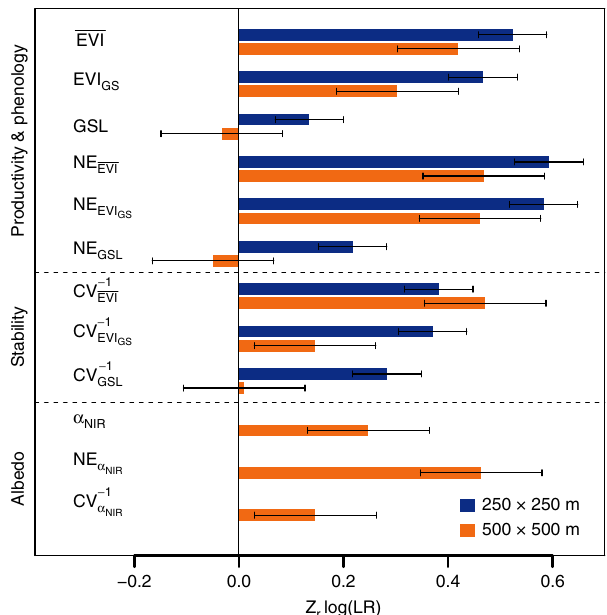
Fig. 4 Normalized effect sizes ( Z r ) of landscape richness for all landscape functioning variables. log(LR): log-transformed landscape richness; EVI : growing-season mean enhanced vegetation index; EVI GS : growing-season integrated enhanced vegetation index; GSL: growing-season length; α NIR : near-infrared albedo. NE: net diversity effects for these variables; CV − 1 : temporal stability of these variables; bars show mean ± s.d. of Z r values; blue: 250 × 250m landscapes ( n = 237 land-cover composition × block combinations); orange: 500 × 500 m landscapes ( n = 77 land-cover composition × block combinations). Source data are provided as a Source Data fi